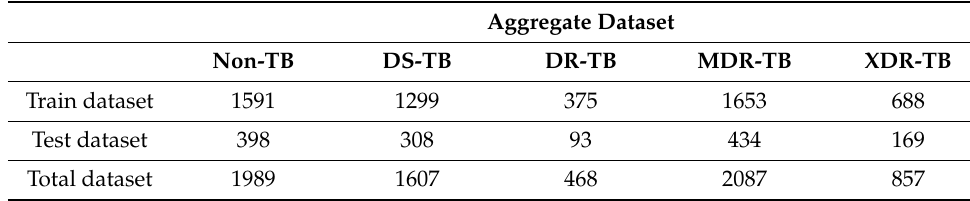
Table 11. Details of the aggregate